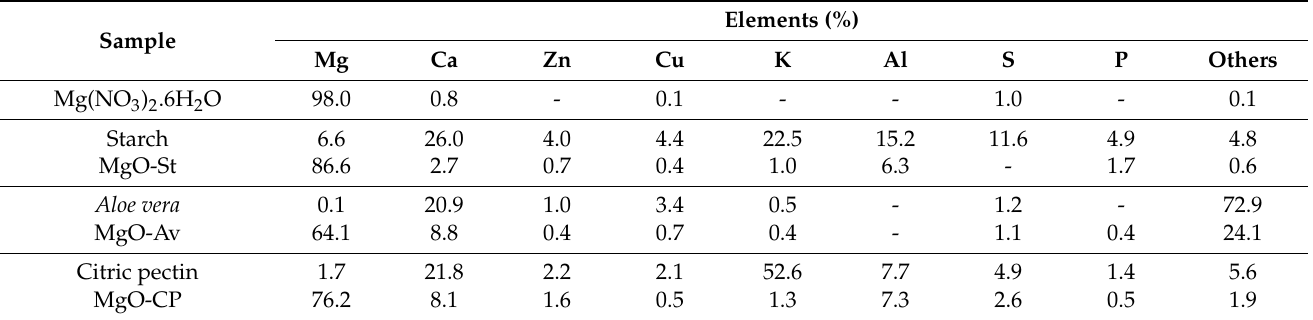
Table 1. Elemental chemical compositions of the synthesized MgO samples and precursors used in the synthesis in element percent (% element) by